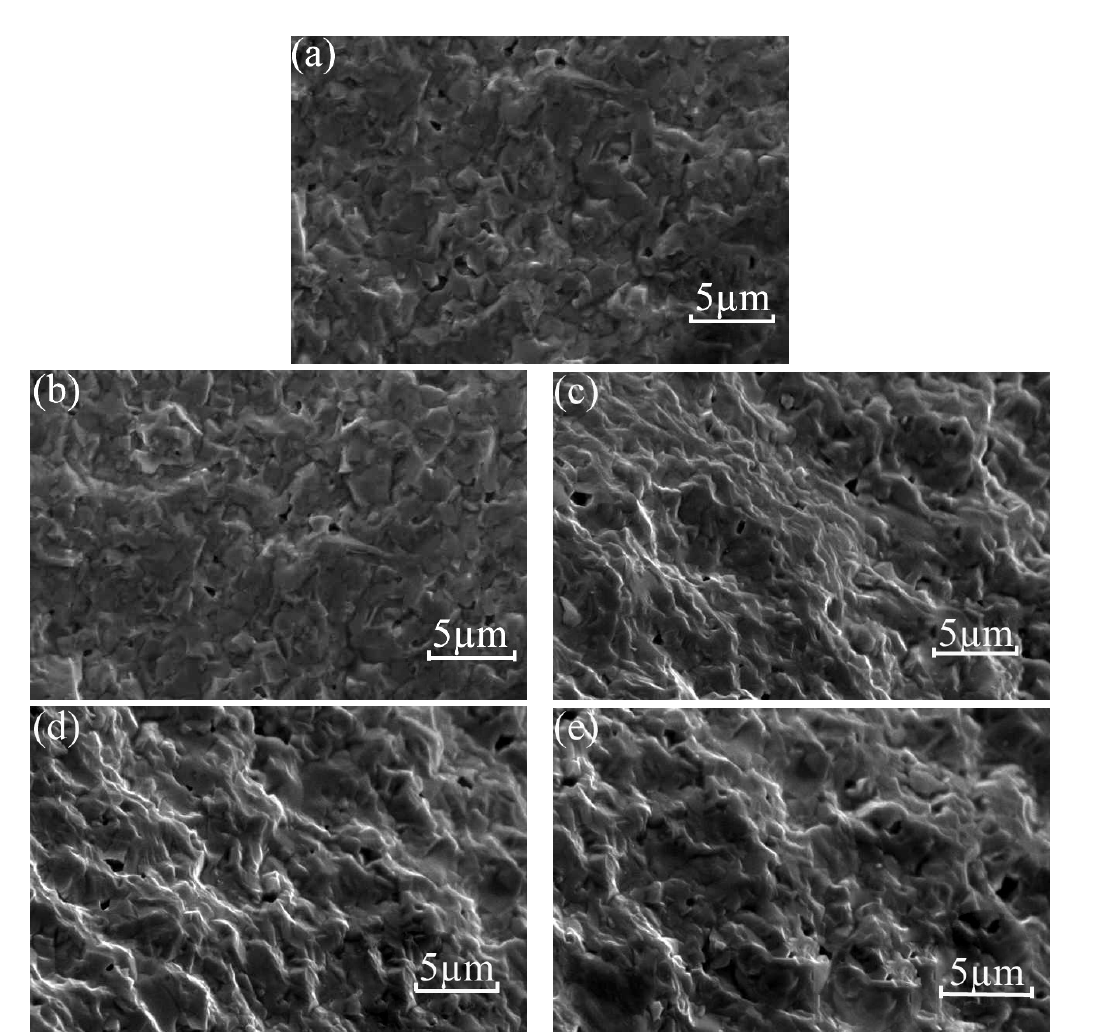
Fig. 4 SEM micrographs of the cross-section of (Ba 1 − x Sr x ) 4 (Sm 0.4 Nd 0.6 ) 28/3 Ti 18 O 54 ceramics with (a) x = 0.02, (b) x = 0.04, (c) x = 0.06, (d) x = 0.08, and (e) x = 0.1, sintered at 1440 ℃ for 4